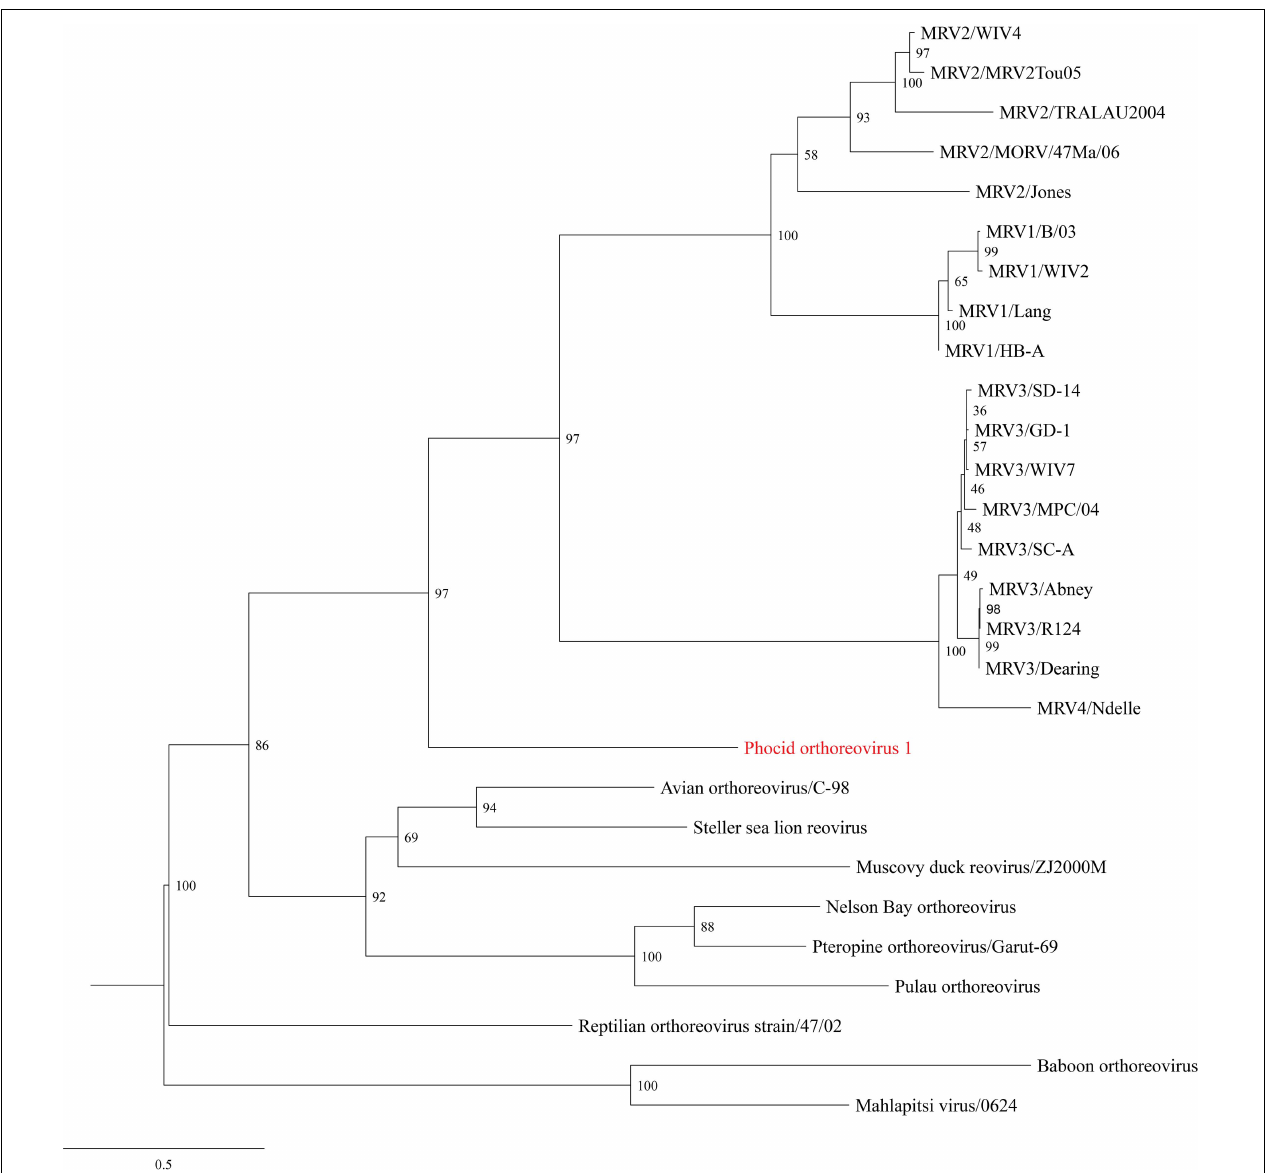
FIGURE 3 | Maximum Likelihood phylogram depicting the relationship of the phocid orthoreovirus 1 (PhRV1) to representatives of the Orthoreovirus genus based on the aligned amino acid sequences of the sigma 1 protein (segment S1). Bootstrap values are given at each node and the branch lengths represent the number of inferred substitutions as indicated by the scale. Viral names are listed, followed by isolate/strain identification when available. Viral abbreviations: MRV1, mammalian orthoreovirus 1; MRV2, mammalian orthoreovirus 2; MRV3, mammalian orthoreovirus 3; MRV4, mammalian orthoreovirus